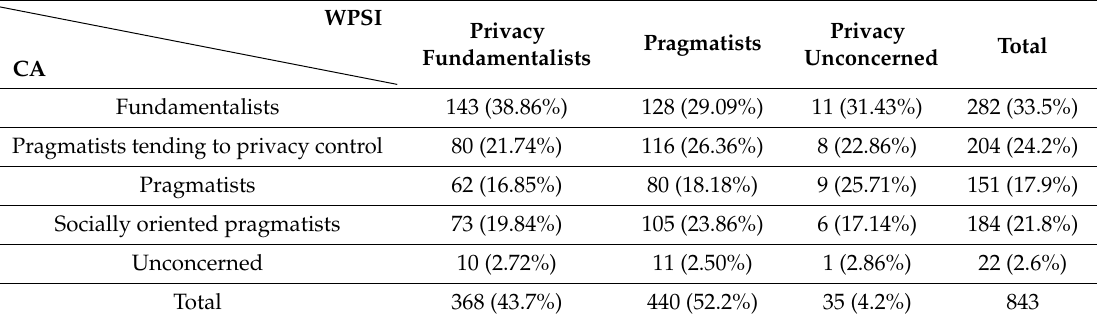
Table 5. Conjoint analysis (CA) vs. Westin Privacy Segmentation Index (WPSI)